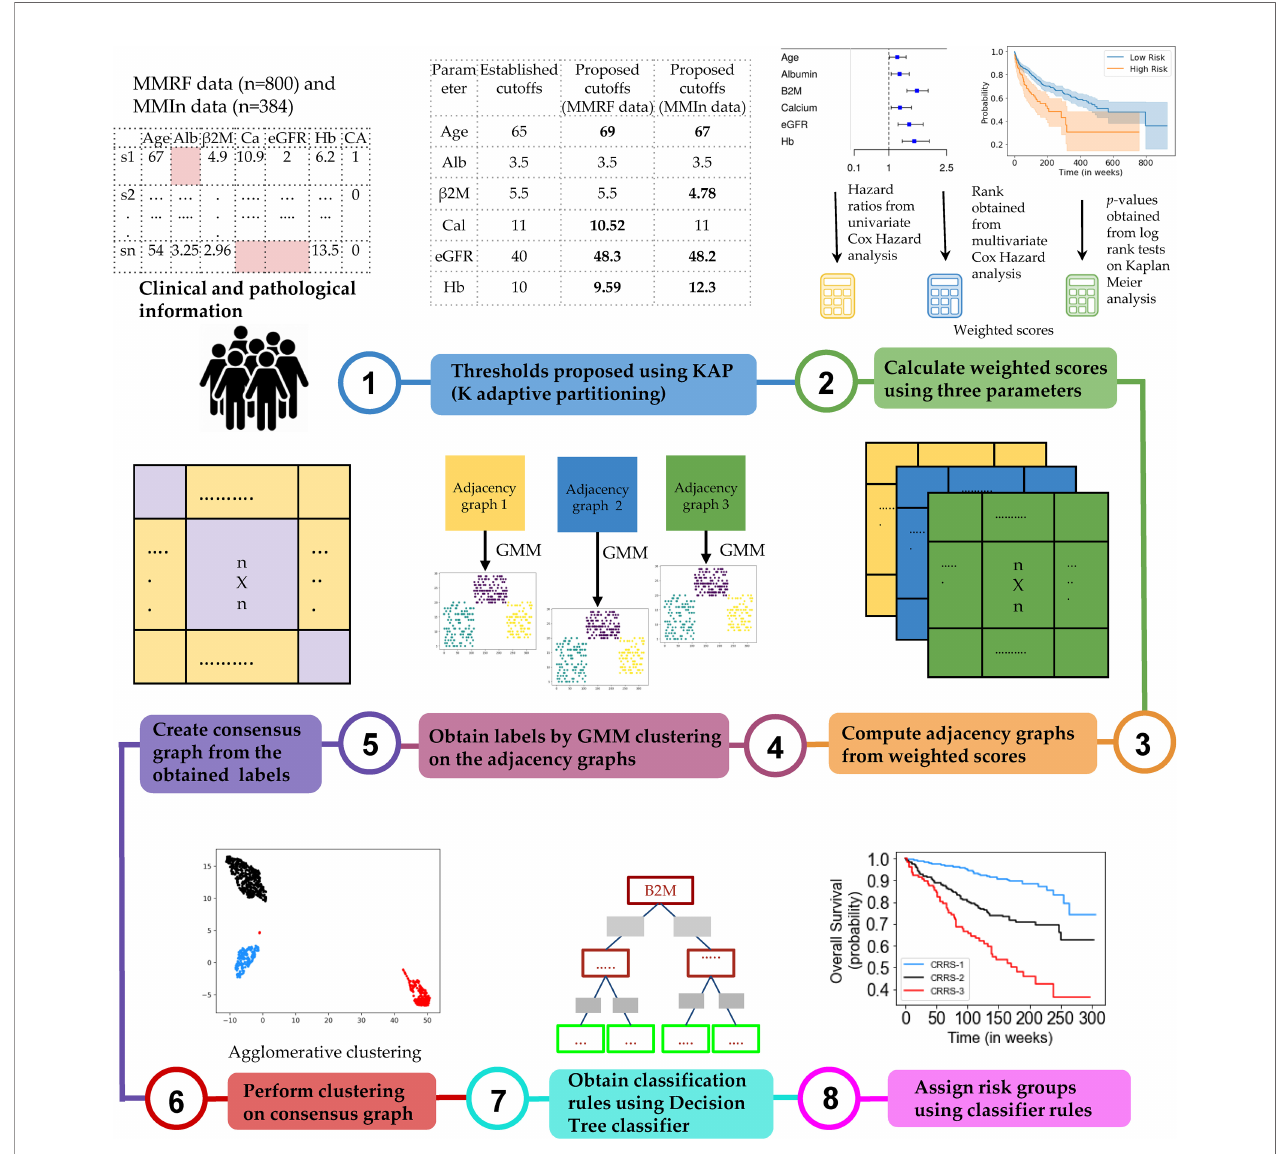
FIGURE 1 | Work fl ow for the development of the Consensus-based Risk-Strati fi cation System (CRSS) for newly diagnosed multiple myeloma